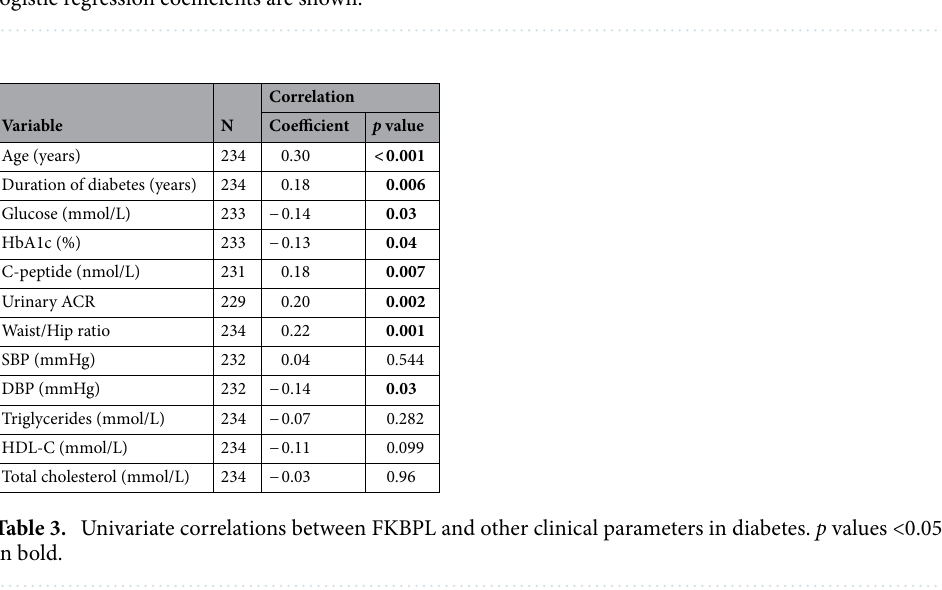
Table 2. Determinants of cardiovascular disease in patients with and without type 2 diabetes—penalised logistic regression coefficients are shown.